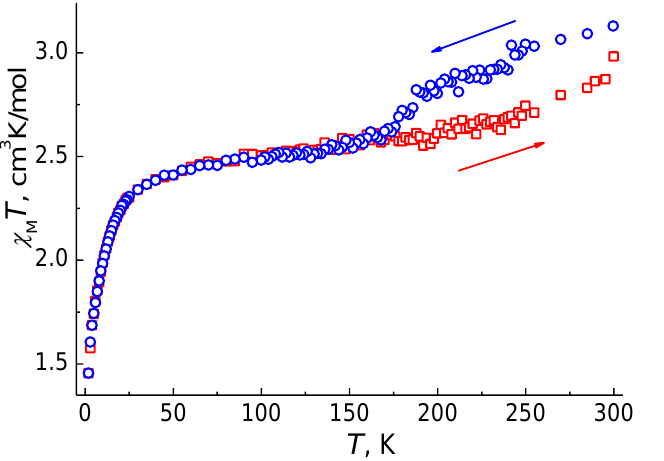
Figure 6. CASSCF/NEVPT2-calculated relative energies of a d-orbitals for α - 1 (red states) and γ - 1 (blue states). Change in the splitting of orbitals for Co1 2+ ion ( a ), and for Co2 2+ ( b ).